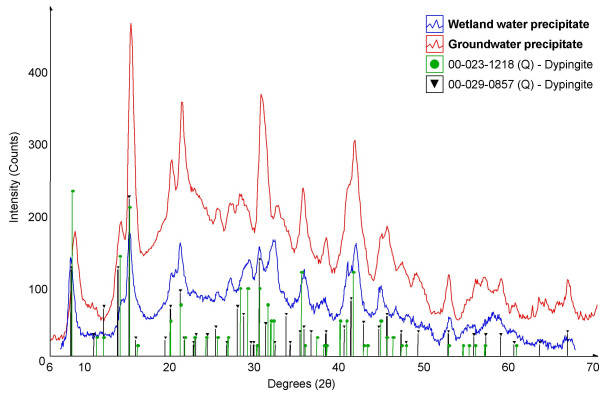
Micro X-ray diffraction pattern of precipitates formed in association with experimental biofilms using wetland and ground waters from the Atlin site. The plot is of background subtracted X-ray intensity versus 2θ and matching mineral phases from the ICDD database shown by stick patterns.